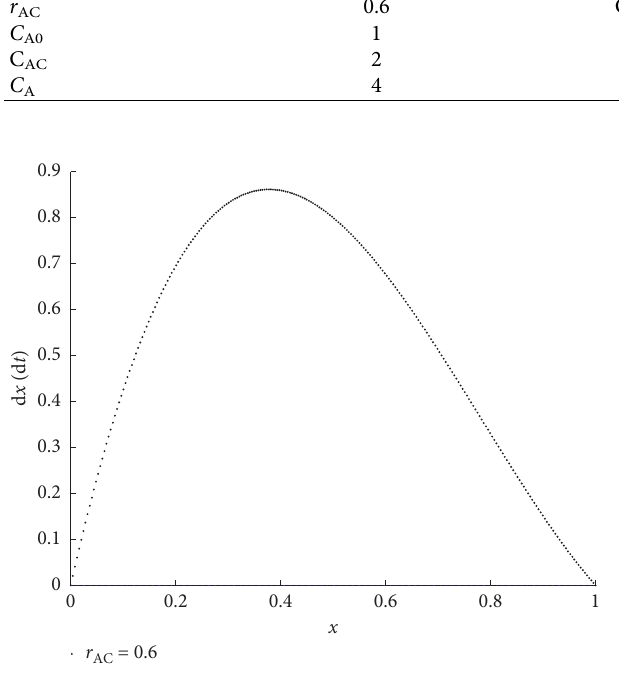
Figure 2: Initial simulation experiments.